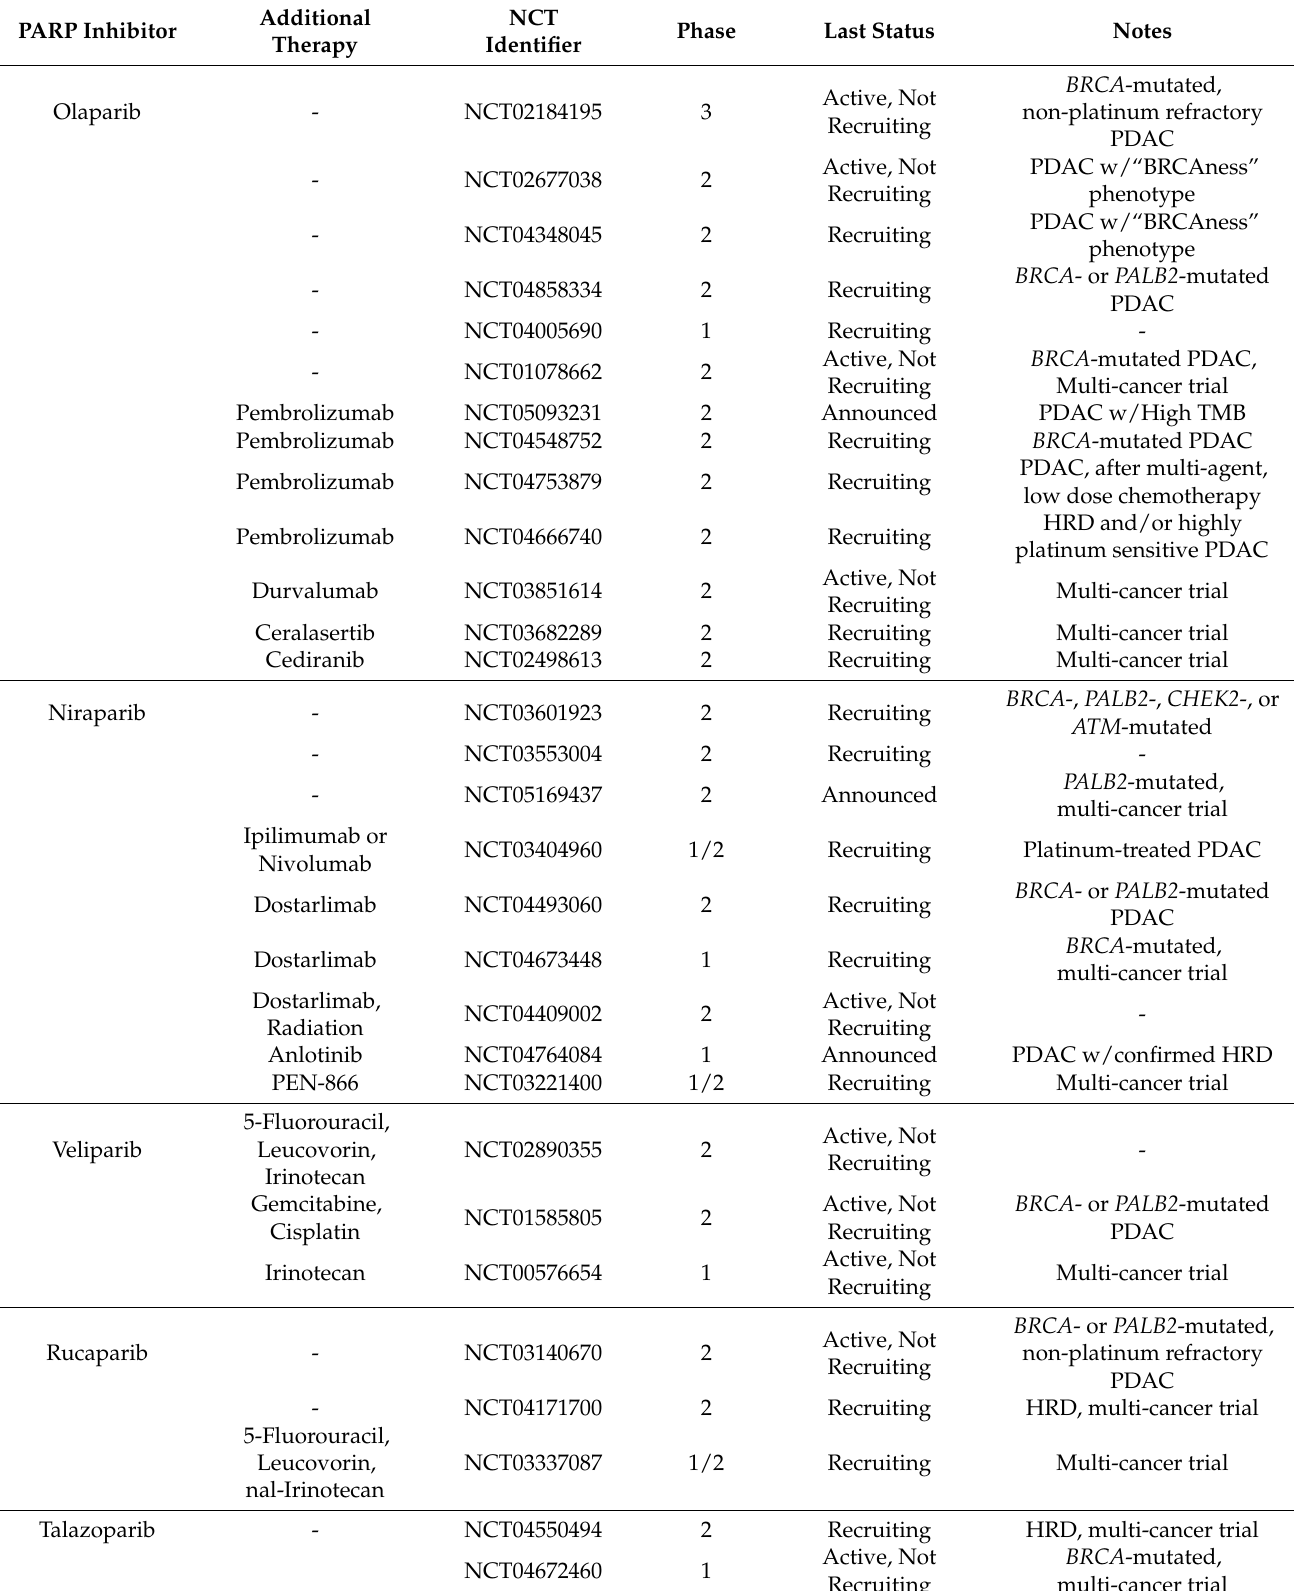
Table 3. Select ongoing clinical trials exploring PARP inhibitors in pancreatic cancer